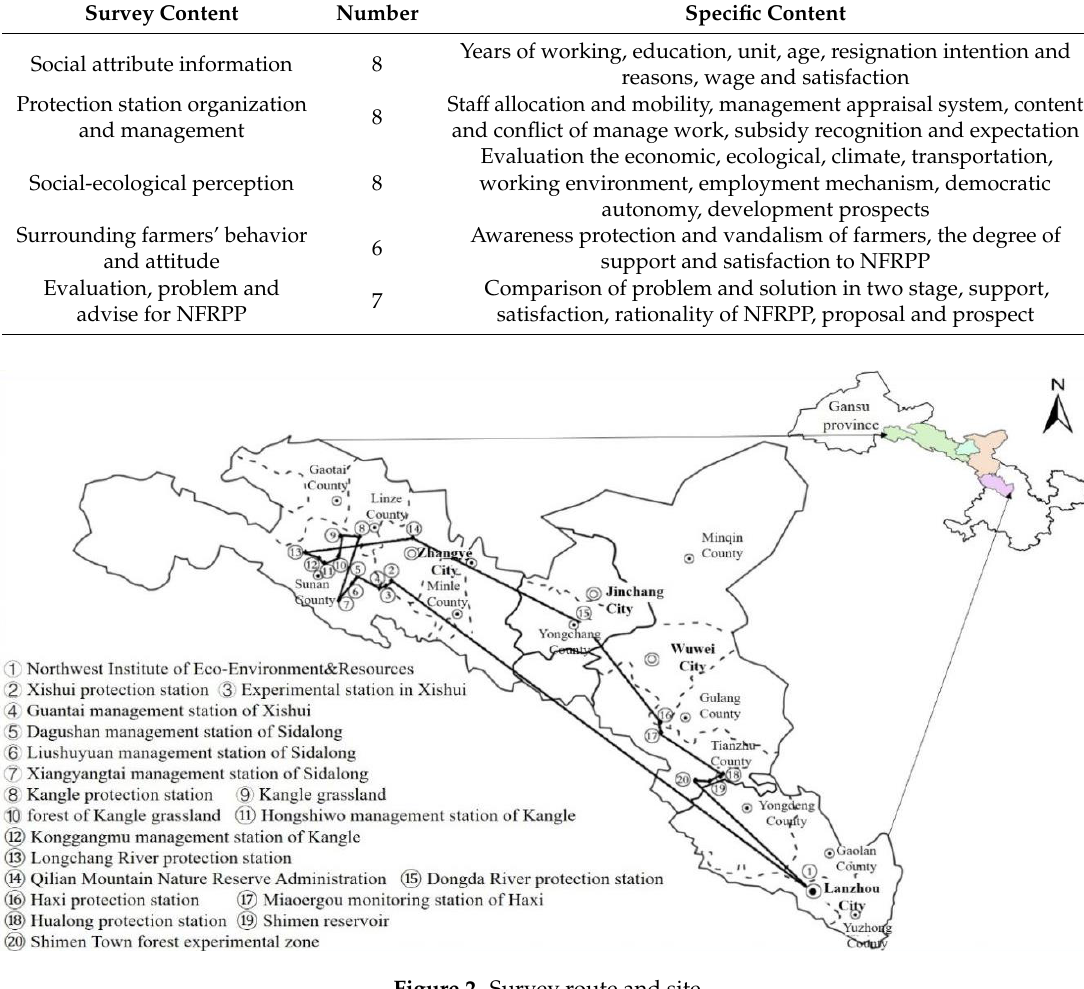
Figure 2. Survey route and site.